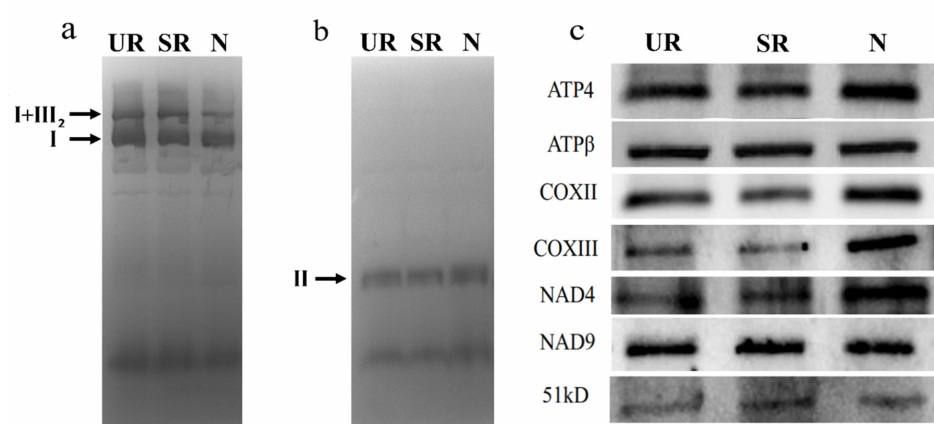
Figure 4. In-gel activity of the mitochondrial respiratory complexes separated by BN-PAGE. Complex I activity ( a ), Complex II activity ( b ), and Western blotting ( c ). UR, uninoculated roots; SR, stripped roots; N, nodules. I, complex I; I + III 2 , supercomplex composed of complex I and dimeric complex III; II, complex II. For Western blotting, 10 µ g mitochondrial proteins were separated by SDS-PAGE and blotted with antibodies. Three biological replicates were run and the results were reproducible. The representative images are shown in ( a – c